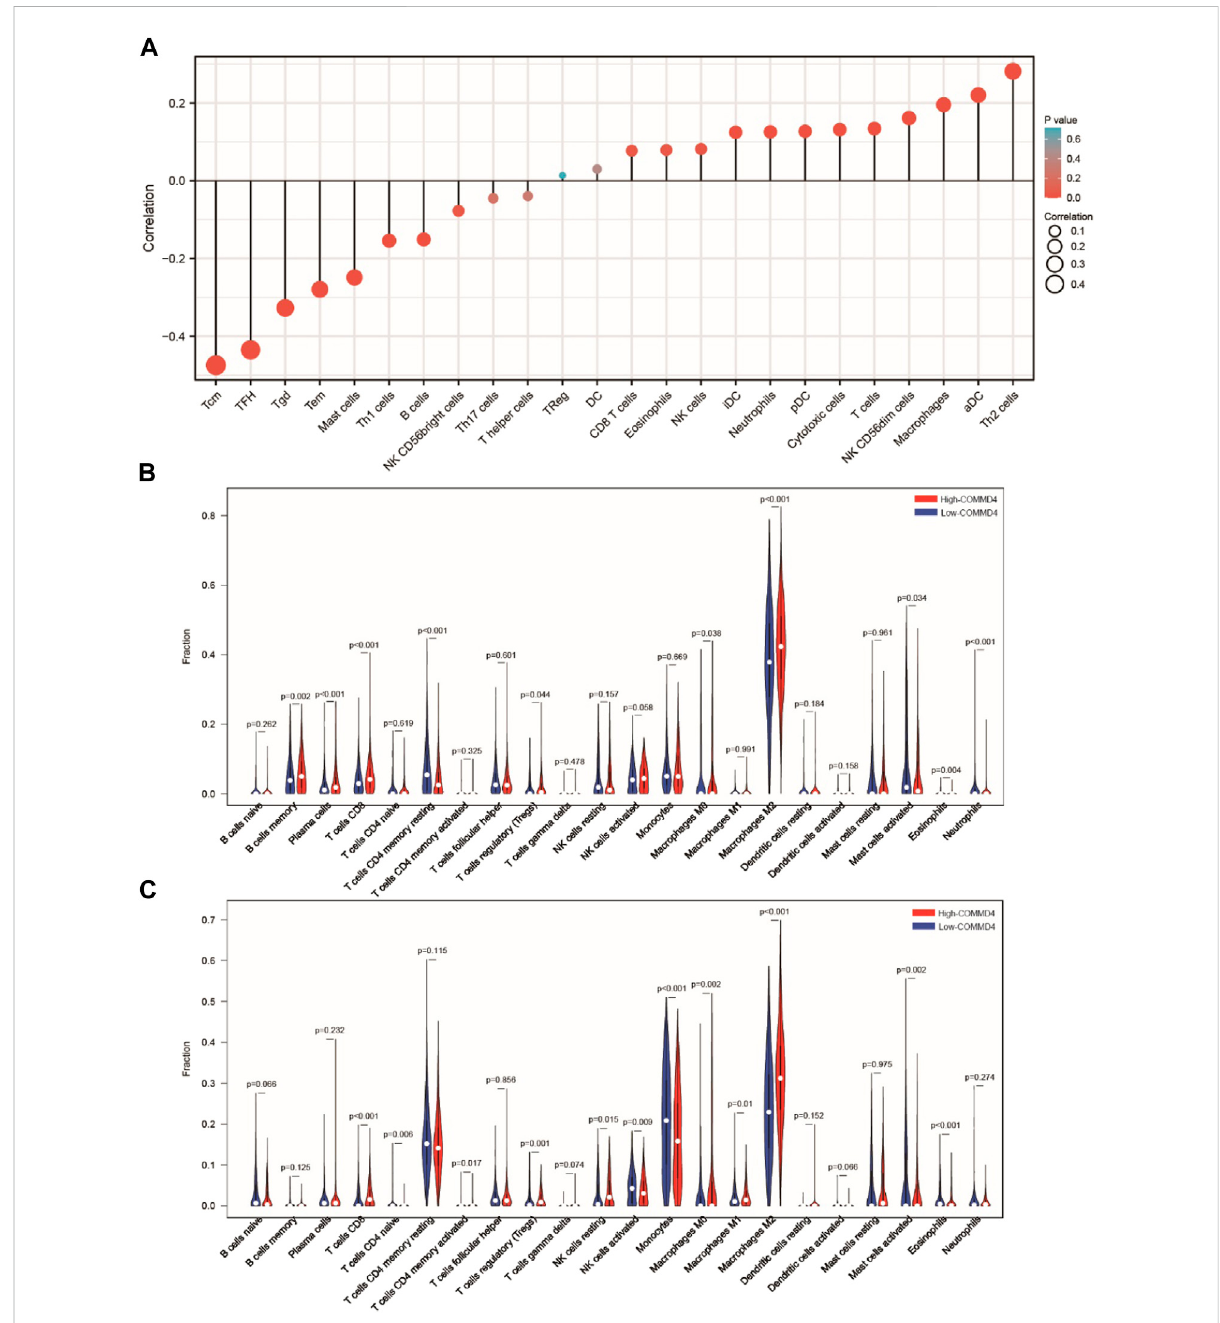
FIGURE 6 (A) The fi ndings of the relative ratios of TIIC computed utilizing the ssGSEA method premised on the TCGA dataset. The relative ratios of TIIC derived utilizing the CIBERSORT method premised on the (B) CGGA and (C) TCGA